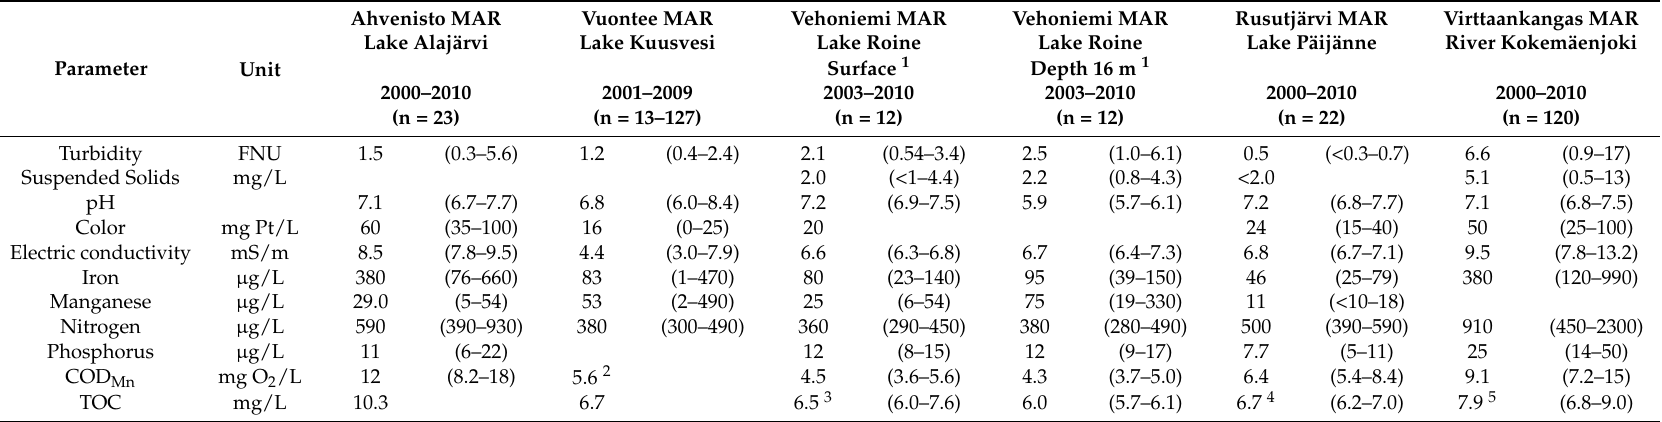
Table 2. Water quality (mean, minimum, and maximum) of the water bodies used as raw water sources of selected MAR plants from 2000 to 2010. Data collected from official monitoring records, except where